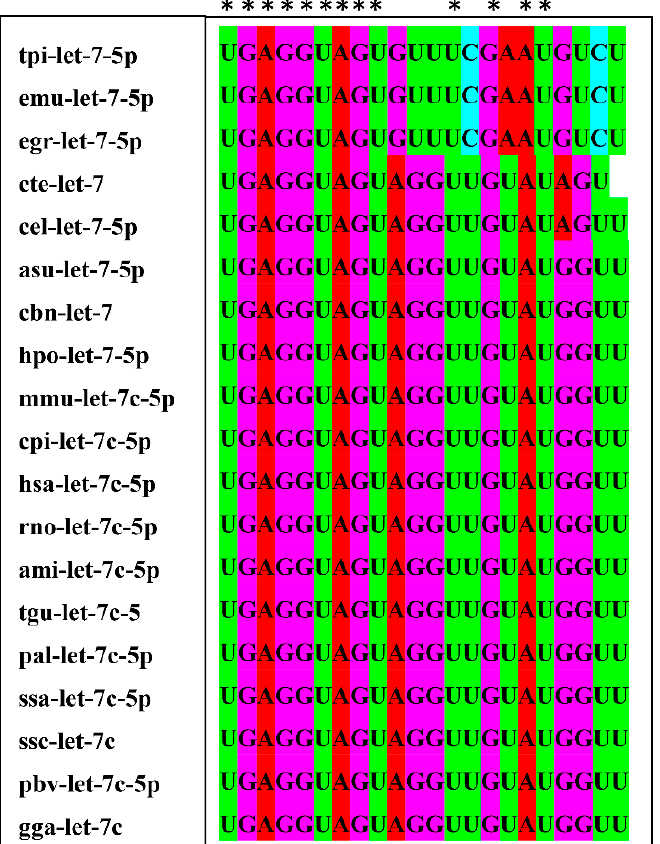
Figure 5. The multi-sequence alignment of let-7 among different species. Identical nucleotides are marked with *. tpi: Taenia pisiformis ; emu: Echinococcus multilocularis ; egr: Echinococus granulosus ; cte: Capitella teleta ; cel: Caenorhabditis elgans ; asu: Ascaris suum ; cbn: Caenorhabditis brenneri ; hpo: Heligmosomoides polygyrus ; mmu: Mus musculus ; cpi: Chrysemys picta ; has: Homo sapiens ; rno: Rattus norvegicus ; ami: Alligator mississippiensis ; tgu: Taeniopygia guttata ; pal: Pteropus alecto ; ssa: Salmo salar ; ssc: Sus scrofa ; pbv: Python bivittatus ; gga: Gallus gallus.